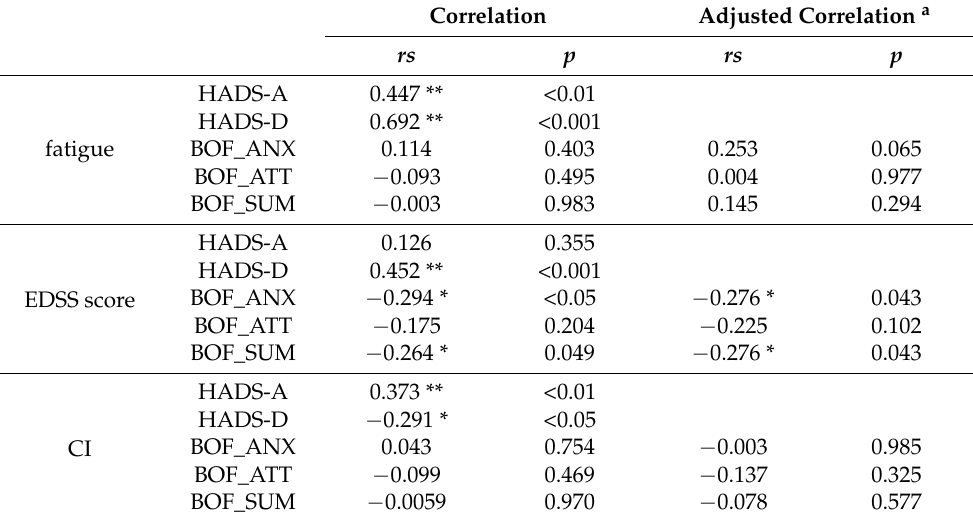
Table 6. Spearman’s bivariate correlation and partial correlation of the three different impair- ment measures: fatigue (MUSIC), disability (EDSS) and cognitive impairment (MUSIC) with the BOFRETTA 2.0 and the HADS (N =